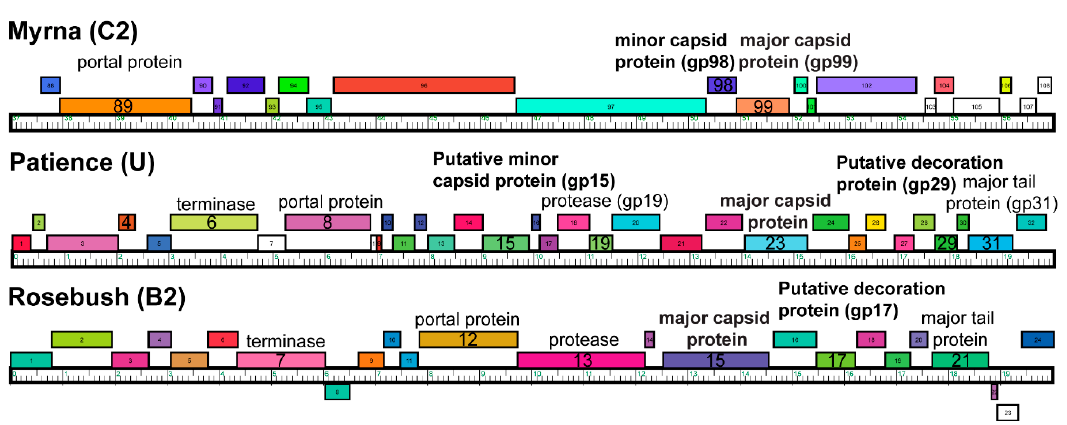
Figure 6. Gene organization of structure proteins. A portion of each bacteriophage genome displayed with the phamerator software [42] showing the positions of the annotated structural proteins.